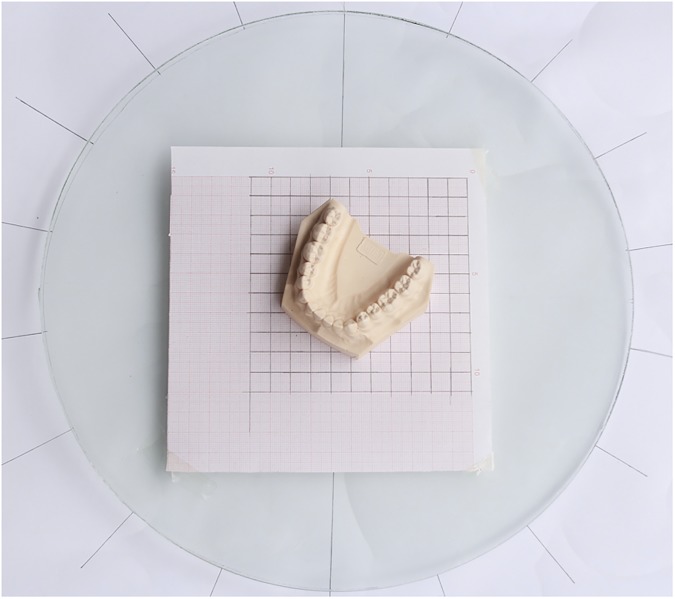
Homemade studio for dental casts photography.